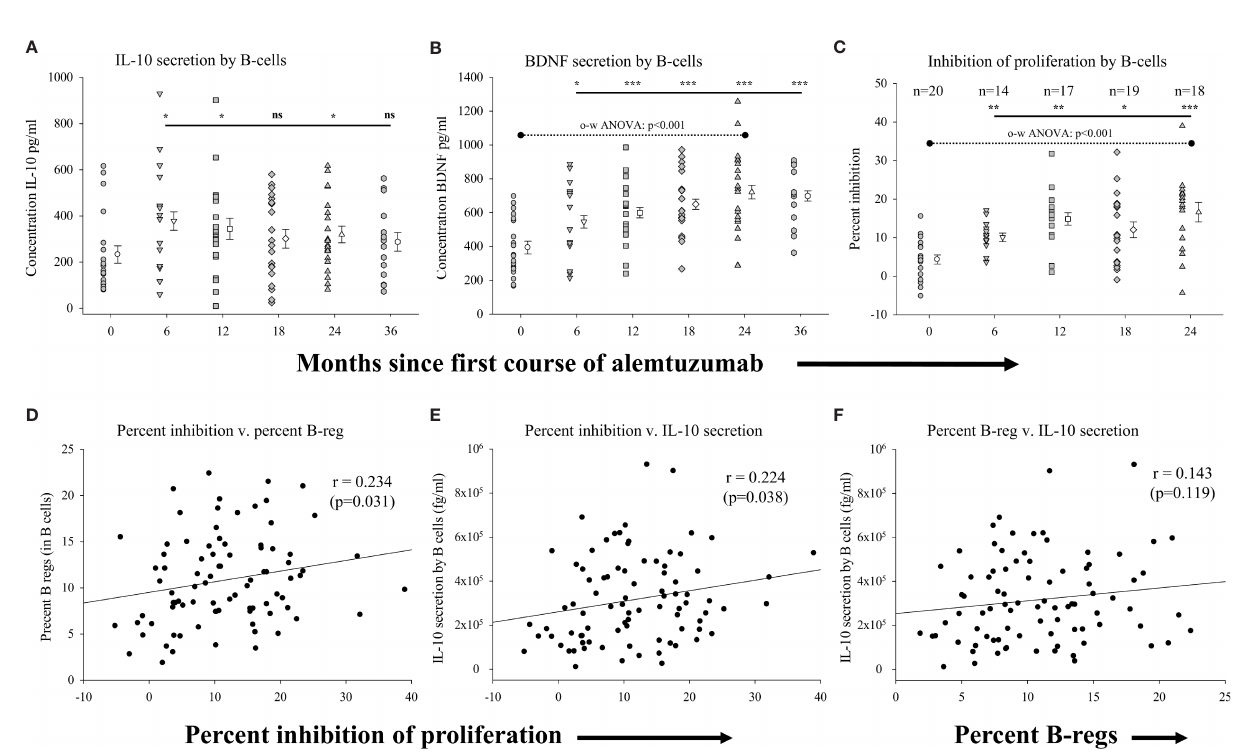
FIGURE 2 | Measures of regulatory B-cell function following alemtuzumab treatment: Panels (A – C) illustrate different measures for each treatment cohort (6 month = inverted triangle; 12 month = square; 18 month = diamond; 24 month = triangle; 36 month = hexagon) as compared with a pre-treated patient cohort (circles). Panels (A) (IL-10) & (B) (BDNF) show the concentration (pg/ml) of solutes secreted by stimulated CD19 + B lymphocytes. Panel (C) shows the percent of inhibition of T cell proliferation by puri fi ed CD19 + B lymphocytes. Data for each cohort in panels (A – C) shows the individual values for each patient in the cohort ( fi lled circles, fi lled triangles etc.) adjacent to the mean ( ± SEM) for the group as a whole (open circles, open triangles etc.). Signi fi cant changes compared to the pre-treated patient cohort are identi fi ed as *** (p ≤ 0.001), ** (p ≤ 0.01), * (p ≤ 0.05) or ns (not signi fi cant), and are plotted above the corresponding cohort on top of the solid back line. One-way ANOVA (panel B) with corresponding p-value is shown with a dashed line across the top of the data points tested. Panels (D – F) show scatter plots and Spearman ’ s Rank-Order correlations (rho (r)) of the (D) percent inhibition of T cell proliferation (x-axis) versus percent of regulatory B lymphocytes, (E) percent inhibition of T cell proliferation (x-axis) versus concentration of IL-10 and (F) percent of regulatory B lymphocytes versus concentration of IL-10 for all data points in the